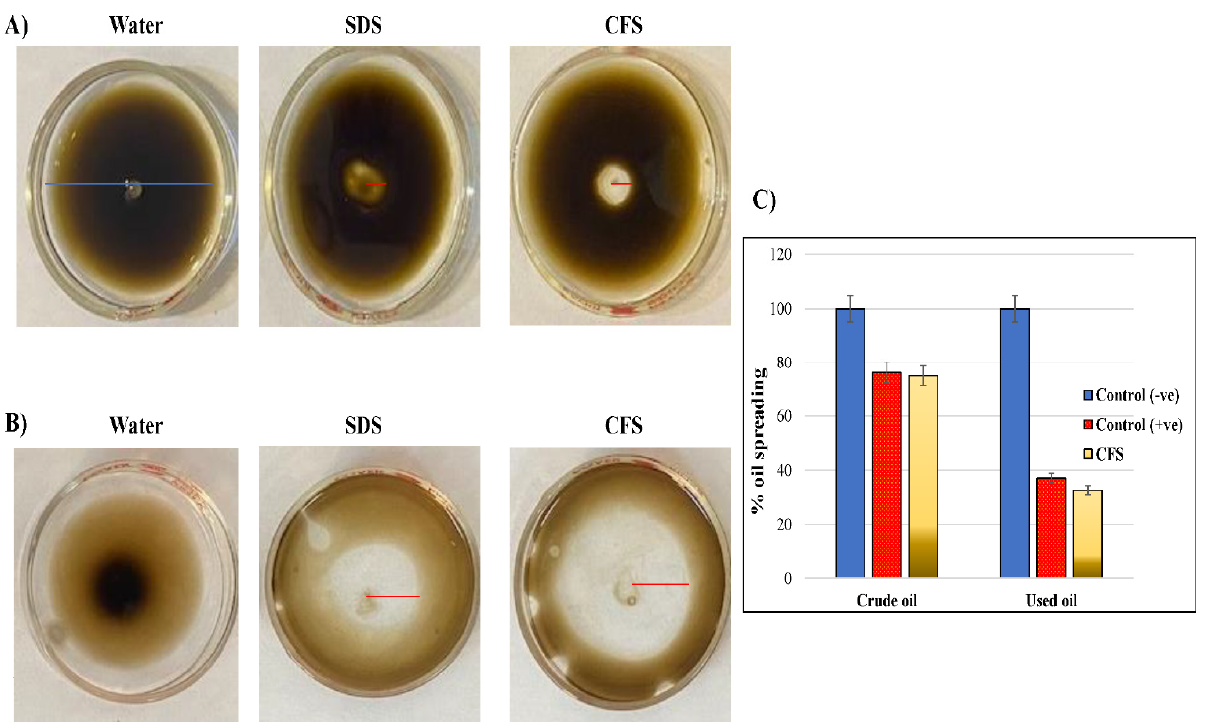
Figure 8. Oil spreading assay. 20 mL of water was added to the petri plate ( ≈ 5 cm × ≈ 5 cm) followed